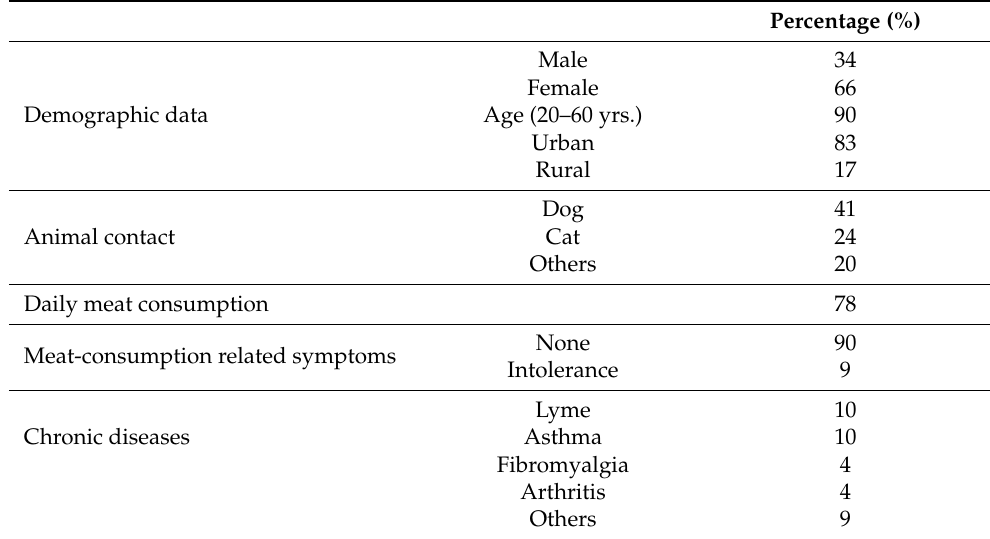
Percentage (%) Male